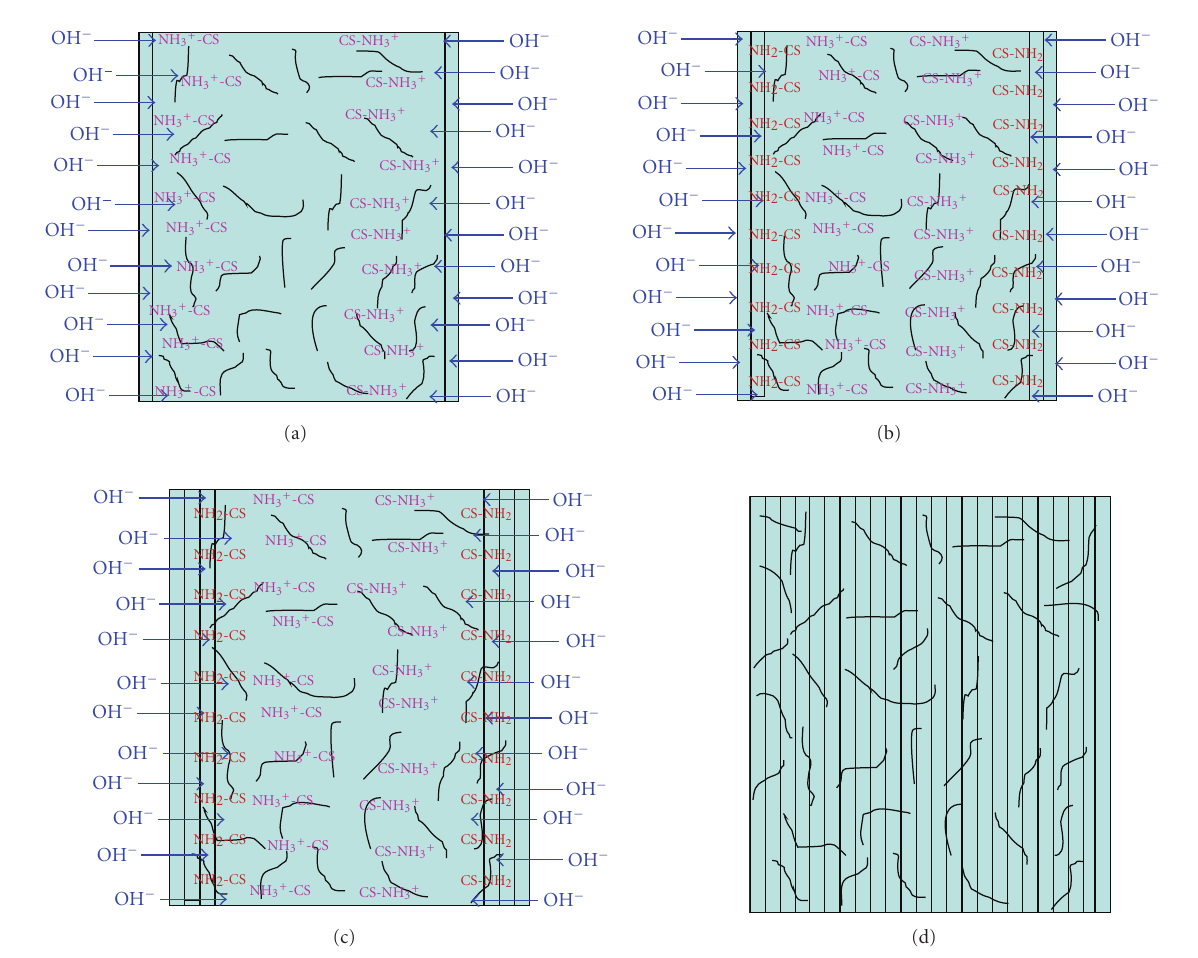
Figure 3: The schematic representation about forming process of CHF/CS gel rod with layer-by-layer structure (vertical section).